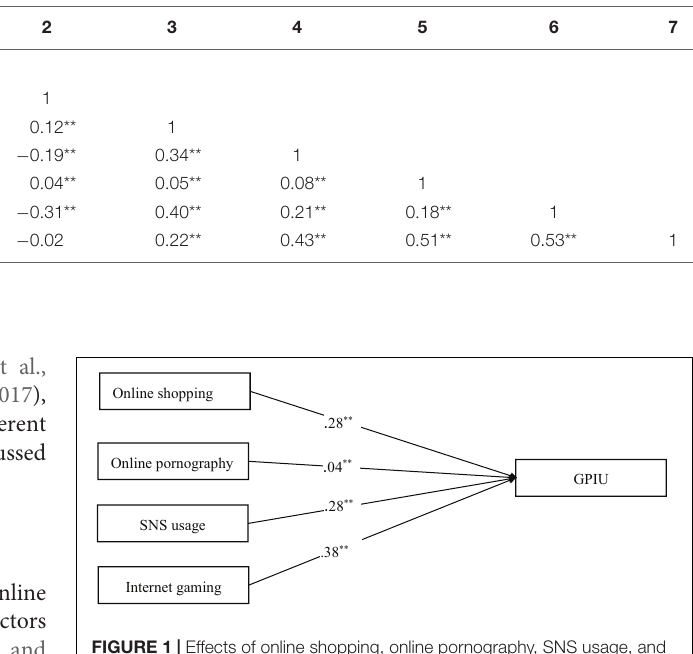
FIGURE 1 | Effects of online shopping, online pornography, SNS usage, and Internet gaming on